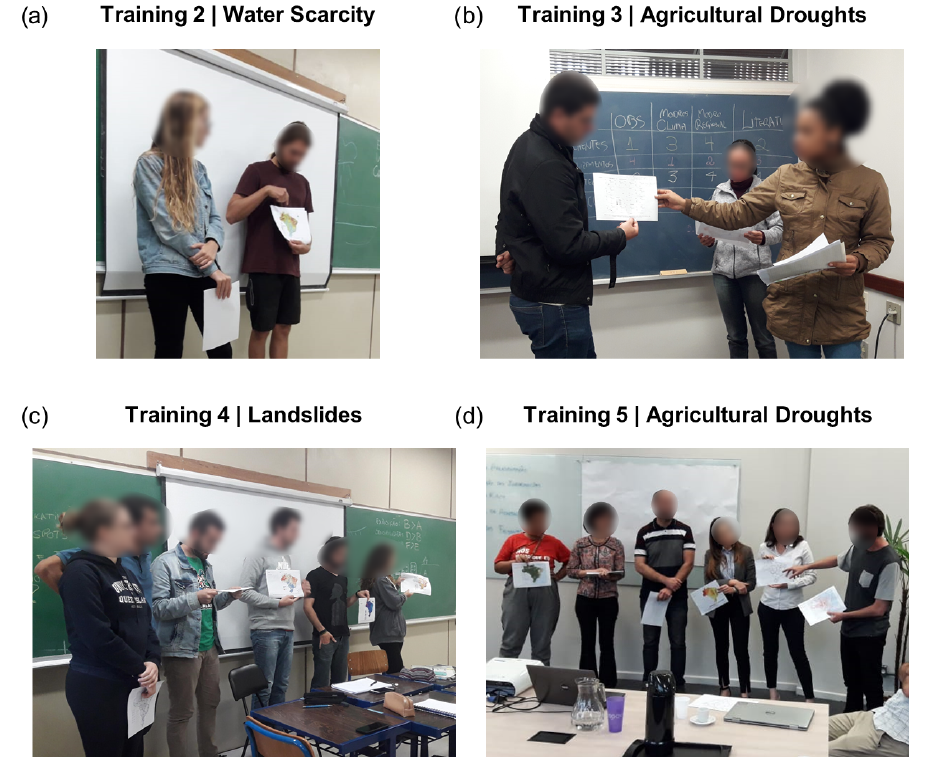
Figure 7. Photos of the participants presenting their